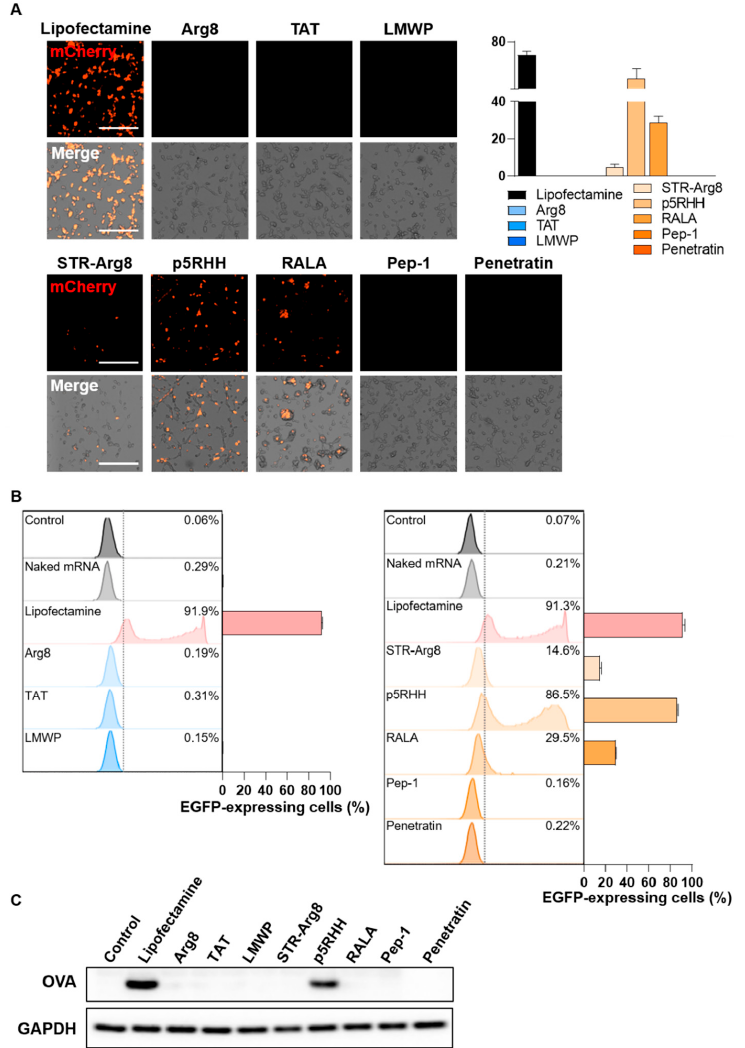
Figure 6. Evaluation of CPP/mRNA-mediated protein expression. ( A ) Representative fluorescence images and a quantitative graph showing mCherry-positive CT26.CL25 cells 24 h after treatment with CPP/mCherry mRNA complexes (6.8 nM). Scale bar: 275 μ m. Data are presented as the mean ± SD ( n = 3). ( B ) Representative flow cytometry histograms and graphs of EGFP-positive CL26.CL25 cells transfected with CPP/EGFP mRNA complexes (6.8 nM). Data are presented as the mean ± SD ( n = 3). ( C ) Western blot analysis of the expression levels of OVA and GAPDH in CT26.CL25 cells. To more precisely quantify the cells expressing the fluorescent protein, we confirmed the number of EGFP-positive cells by flow cytometry (Figure 6B). Consistent with the flu- orescence image results, less than 1% EGFP-positive cells were found in all cationic CPPs and two amphipathic CPPs (Pep-1 and Penetratin) treated groups. On the other hand, the treatment of STR-Arg8, p5RHH and RALA complexes induced EGFP expressions of 14.6, 86.5 and 29.5%, respectively. Notably, the transfection efficiency of p5RHH was as effec- tive as that of Lipofectamine, and this result is consistent with previous reports that p5RHH/siRNA or mRNA nanocomplexes effectively facilitate endosomal lysis and escape